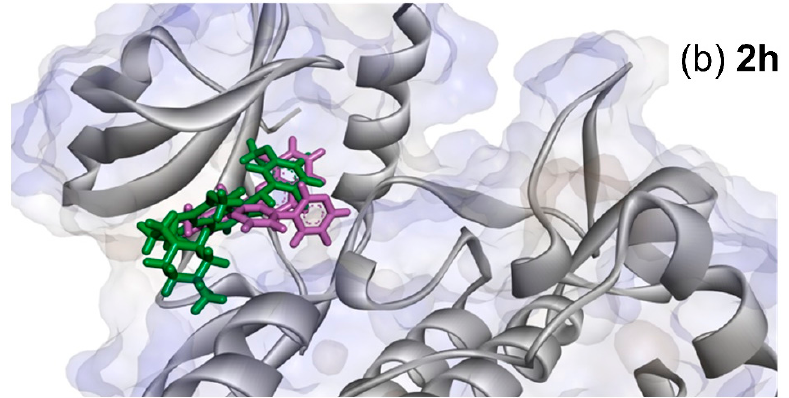
Figure 9. Overlays of the predicted poses of the BCR-ABL1 inhibitors: ( a ) BST (green) and 2g (blue) and ( b ) BST (green) and 2h (pink). The inhibitor structures are in stick representation.